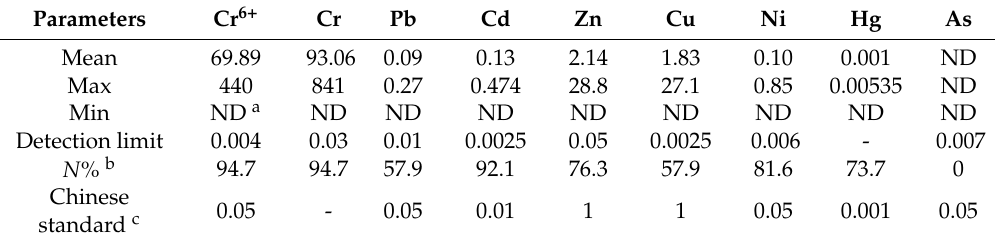
Table 3. Toxic metal concentrations in groundwater samples ( N = 38) from the brownfield (mg/L). Parameters Cr 6+ Cr Pb Cd Zn Cu Ni Hg As Mean 69.89 93.06 0.09 0.13 2.14 1.83 0.10 0.001 ND Max 440 841 0.27 0.474 28.8 27.1 0.85 0.00535 ND Min ND a ND ND ND ND ND ND ND ND Detection limit 0.004 0.03 0.01 0.0025 0.05 0.0025 N % b 94.7 94.7